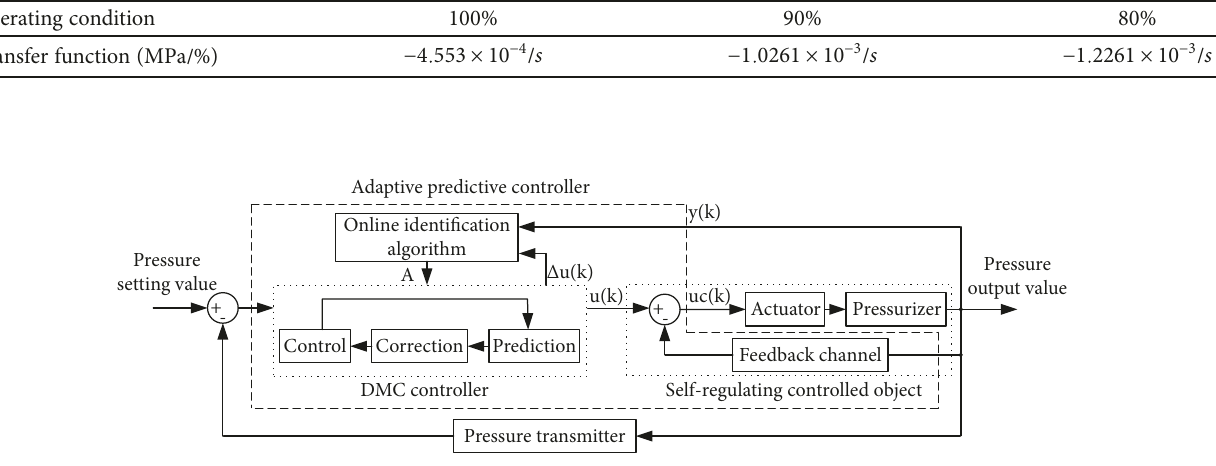
Figure 4: Structure of control system based on adaptive predictive